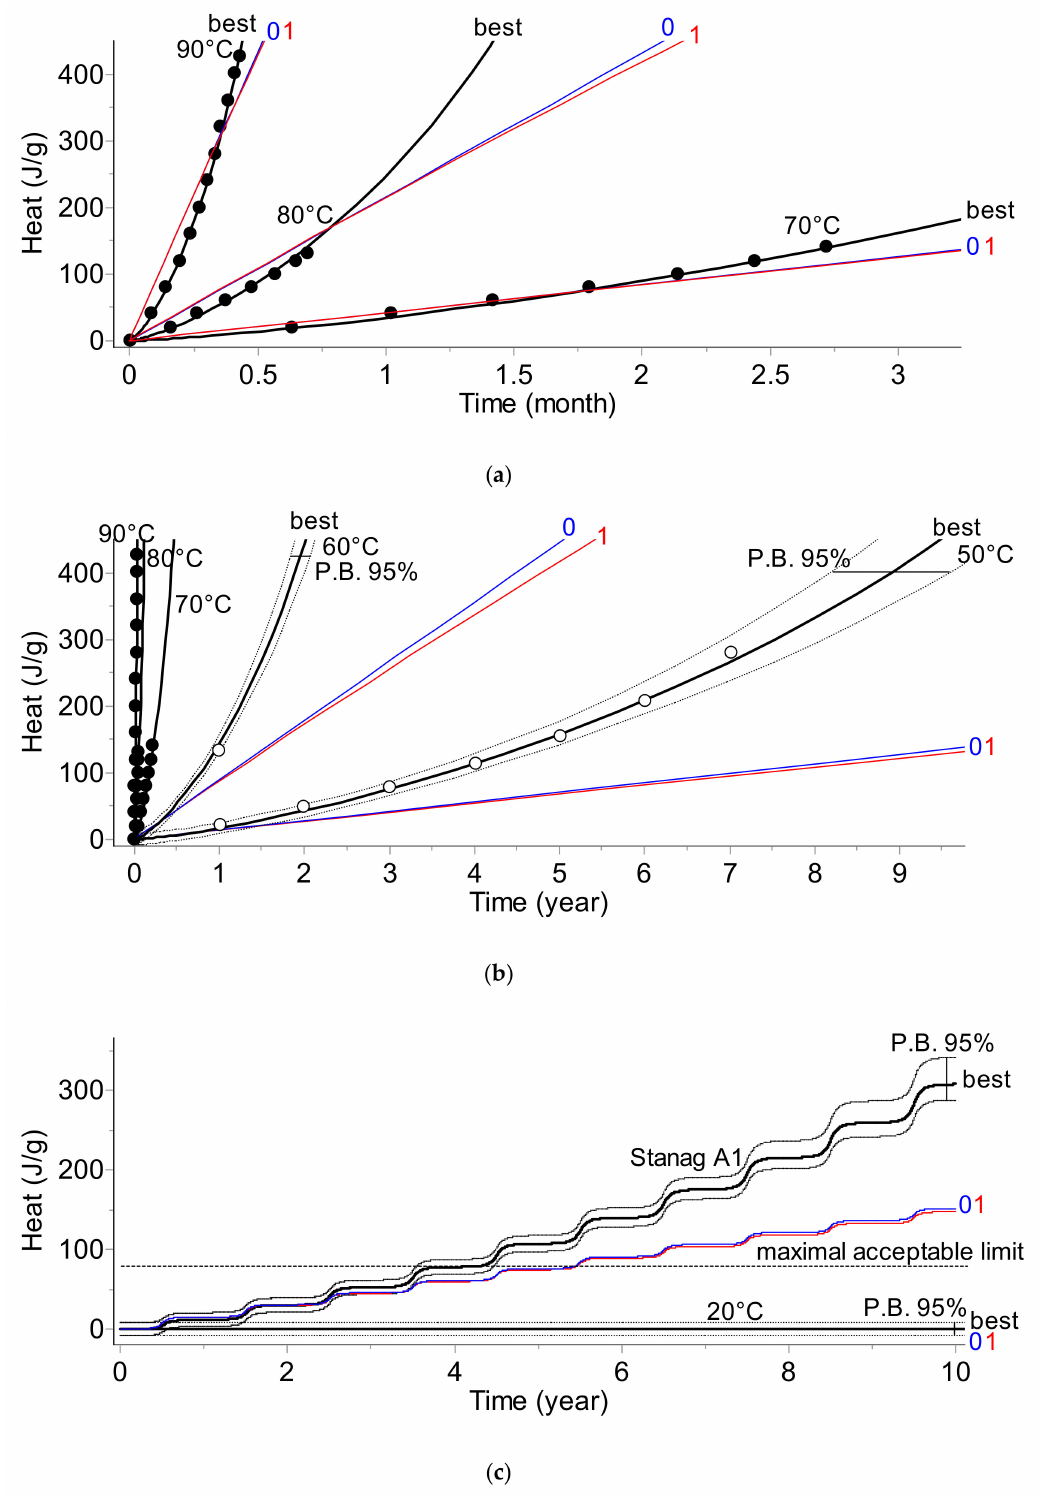
Figure 4. Heat evolution (HFC) test. ( a ) The fit of experimental data collected at 90, 80, and 70 ◦ C by the best (bold), 0th, and 1st order models. ( b ) Prediction of the long-term reaction course for temperatures in the range of 90–50 ◦ C. The predictions for 60 and 50 ◦ C are verified by experimental data marked as empty circles collected once a year. ( c ) 10-year predictions for 20 ◦ C and climate category STANAG